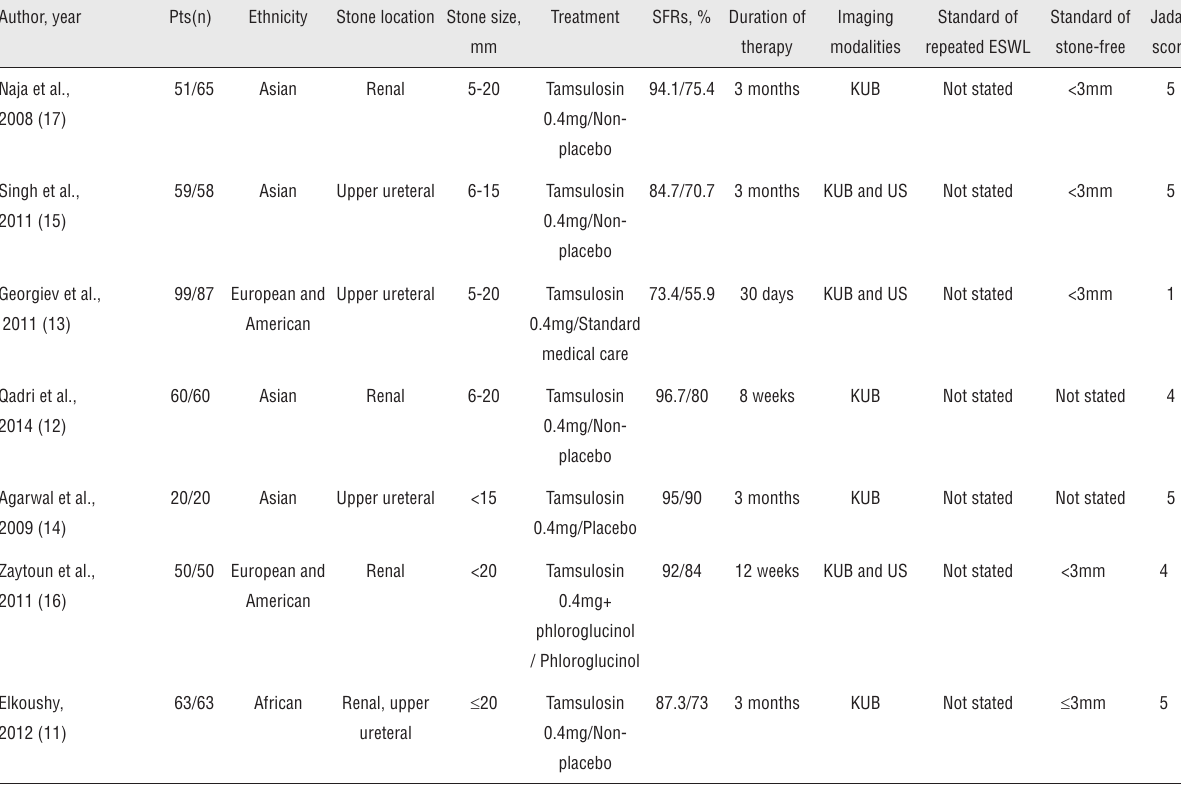
Table 1 - Characteristics of included